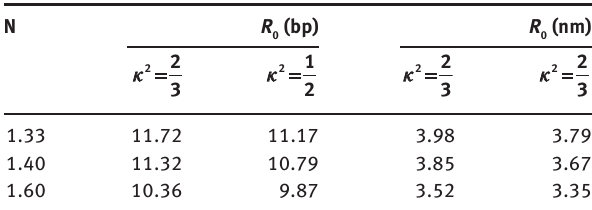
for different n and k 2 . 0